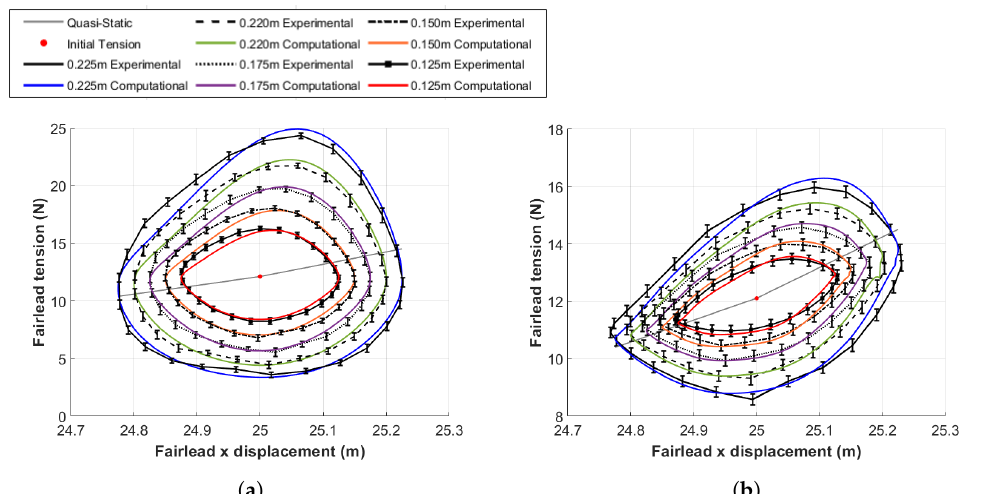
Figure 23. Comparison between the computed fairlead tension values and the experimental mea- surements with clumped weight in configuration 1 for different oscillation amplitudes A = 0.225, 0.220, 0.175, 0.150, 0.125 m and two different periods T = 2.8, 5.5 s for the isolated mooring line. ( a ) T = 2.8 s. ( b ) T = 5.5 s.